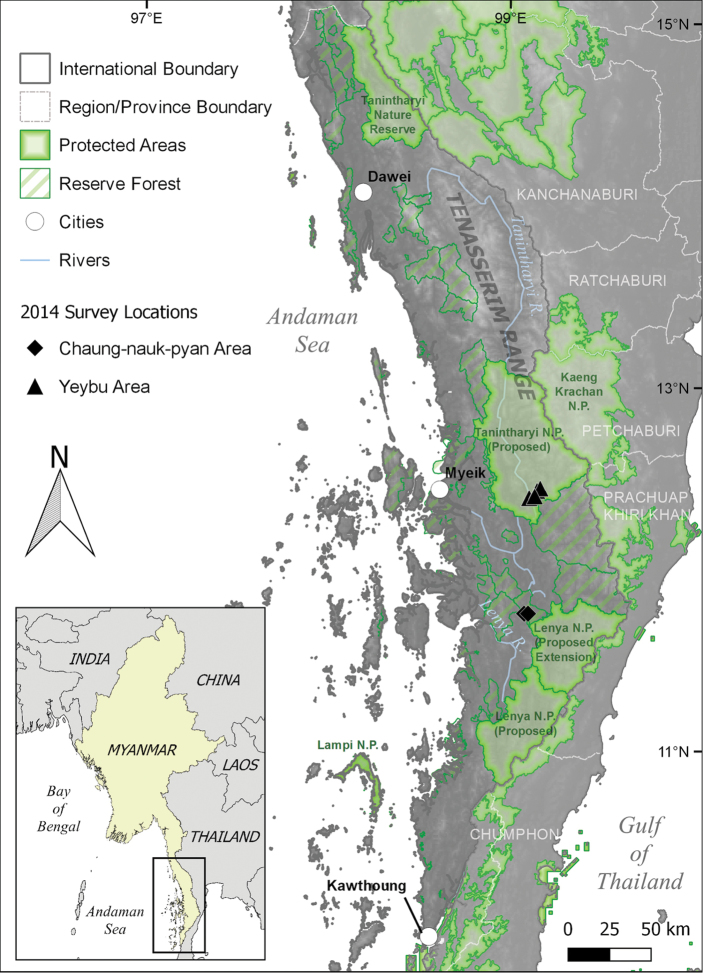
Map of Tanintharyi Region, Myanmar. The Tanintharyi Nature Reserve, north of Dawei, and the Lampi National Park, island northwest of Kawthoung, are officially designated as national parks in Myanmar. The other areas in Myanmar are proposed as national parks (Protected Areas) or being considered for future protection (Reserve Forests). The main survey reported here was conducted in the Yeybu area of the proposed Tanintharyi National Park (triangles: Forest 1–2 and Gardens sites). A shorter survey, with fewer people, was conducted in the Reserve Forest near the Chaung-nauk-pyan area (diamonds: Forest 3 and slash & burnt sites) and is also included in this report. Map provided by Grant M. Connette of the Smithsonian Conservation Biology Institute (SCBI).